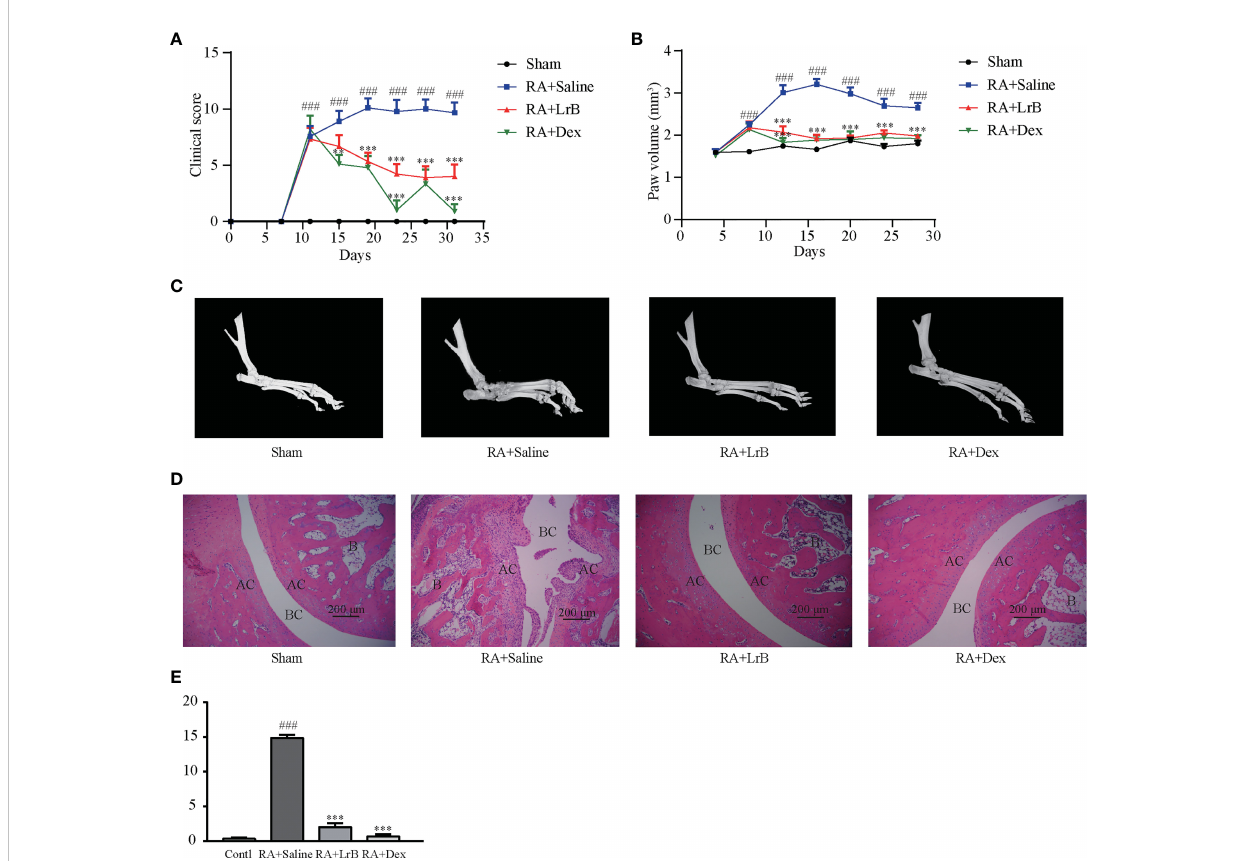
FIGURE 2 LrB alleviated the progression of rheumatoid arthritis. (A) Diagram of the average clinical scores in CIA rats. The degree of joint swelling in CIA rats is scored on a scale of 0 to 4, with 0 points: no arthritis; 1 point: redness and swelling of the little toe joint; 2 points: redness and swelling of the little toe joint and plantar; 3 points: swelling of the paws below the ankle joint; 4 points: the entire toe joint is swollen. (B) Diagram of the average toe swelling volume (mm 3 ) in CIA rats. (C) The hind feet of rats scanned with micro-CT. The bones and joints of the rats in the control, LrB and Dex treatment group were smooth and no bone hyperplasia or osteoporosis were observed, CIA model group showed rough articular surfaces, thickened bones, and severe bone erosion. (D) HE staining of rat joint sections, the abbreviations in the images are Bone (B), articular cartilage (AC), and bone cavity (BC). The articular cartilage structure of the rats in the control, LrB and Dex groups were clear, the synovium showed no hyperplasia or bone erosion, and there was no in fl ammatory cell in fi ltration in the tissue. The synovial membrane of the rats in the CIA model group showed abnormal hyperplasia, villi-like protrusions, a large number of in fl ammatory cells in fi ltrating the joints, and severe cartilage and bone erosion. (E) Total histological score of CIA rats according to the diseased arthritic in fi ltrates, synovial hyperplasia, cartilage damage and bone resorption. (Results are expressed as the mean ± SEM, and tested with One Way ANOVA. ###, P ≤ 0.001, compared to the Sham group; * * P ≤ 0.01, * * * P ≤ 0.001, compared to the RA+Saline